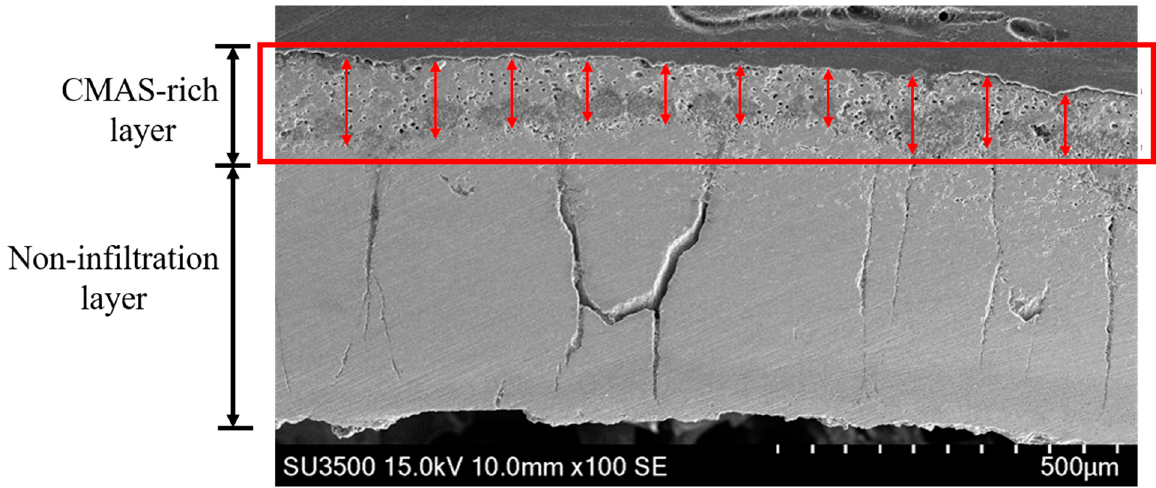
Figure 2. SEM images of free-standing SPS 7YSZ TBCs infiltrated by CMAS for 4 h of holding time.